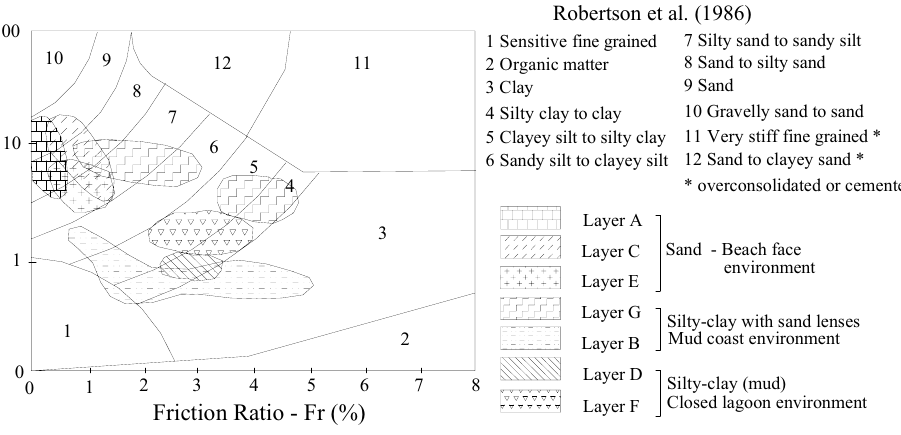
Fig. 6 – Robertson et al. (1986) classification chart and Caravelas site sediment